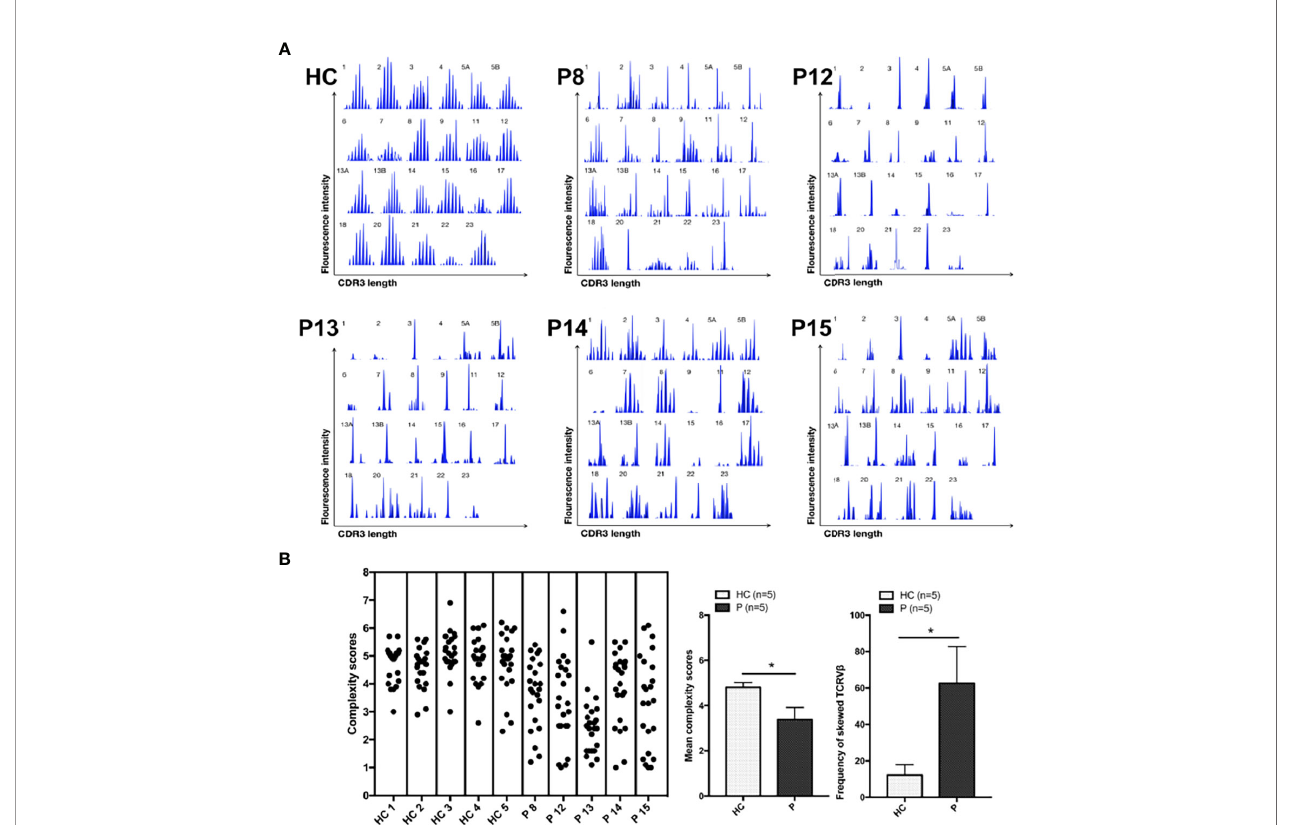
FIGURE 2 | TCR-V b analysis. (A) All 23 TCR-V b subfamilies in the healthy controls exhibited a Gaussian distribution. CDR3 size distribution of the TCR-V b subfamilies in patients P8, P12, P13, P14, and P15. (B) The complexity scores for each healthy control subject (left) and patient (right) are shown. The mean (range) complexity scores of the patient and control groups are shown in the histogram. The frequencies of TCR-V b subfamilies with skewed CDR3 length patterns are shown in the histogram, as determined by a complexity score <4. HC, healthy control subjects; P, patients. * p <